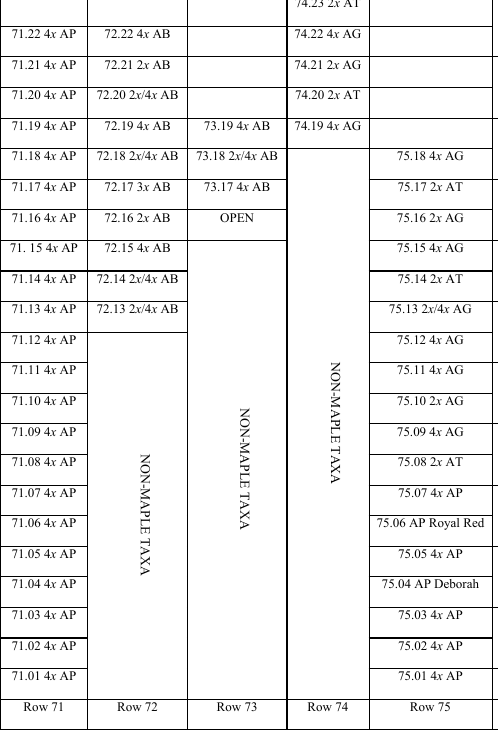
Figure 4. Field map for Acer buergerianum (AB), Acer tataricum ssp. ginnala (AG), A. platanoides (AP), and A. tataricum (AT) at the Lewis Brown Horticulture Research Farm, Corvallis, OR including diploids (2 x ), triploids (3 x ), mixoploids (2 x /4 x ) and tetraploids (4 x ). For Row 71, all tetraploids were derived from Jefferson St. seed source except 71.02, 71.10, 71.12, and 71.22, which were derived from ‘Crimson King’. Trees 75.01, 75.03, and 75.07 were derived from the Jefferson St. seed source and trees 75.02 and 75.05 were derived from ‘Crimson King’. For Row 76, all tetraploids were derived from Jefferson St. seed source except 76.05, which was derived from ‘Crimson King’.